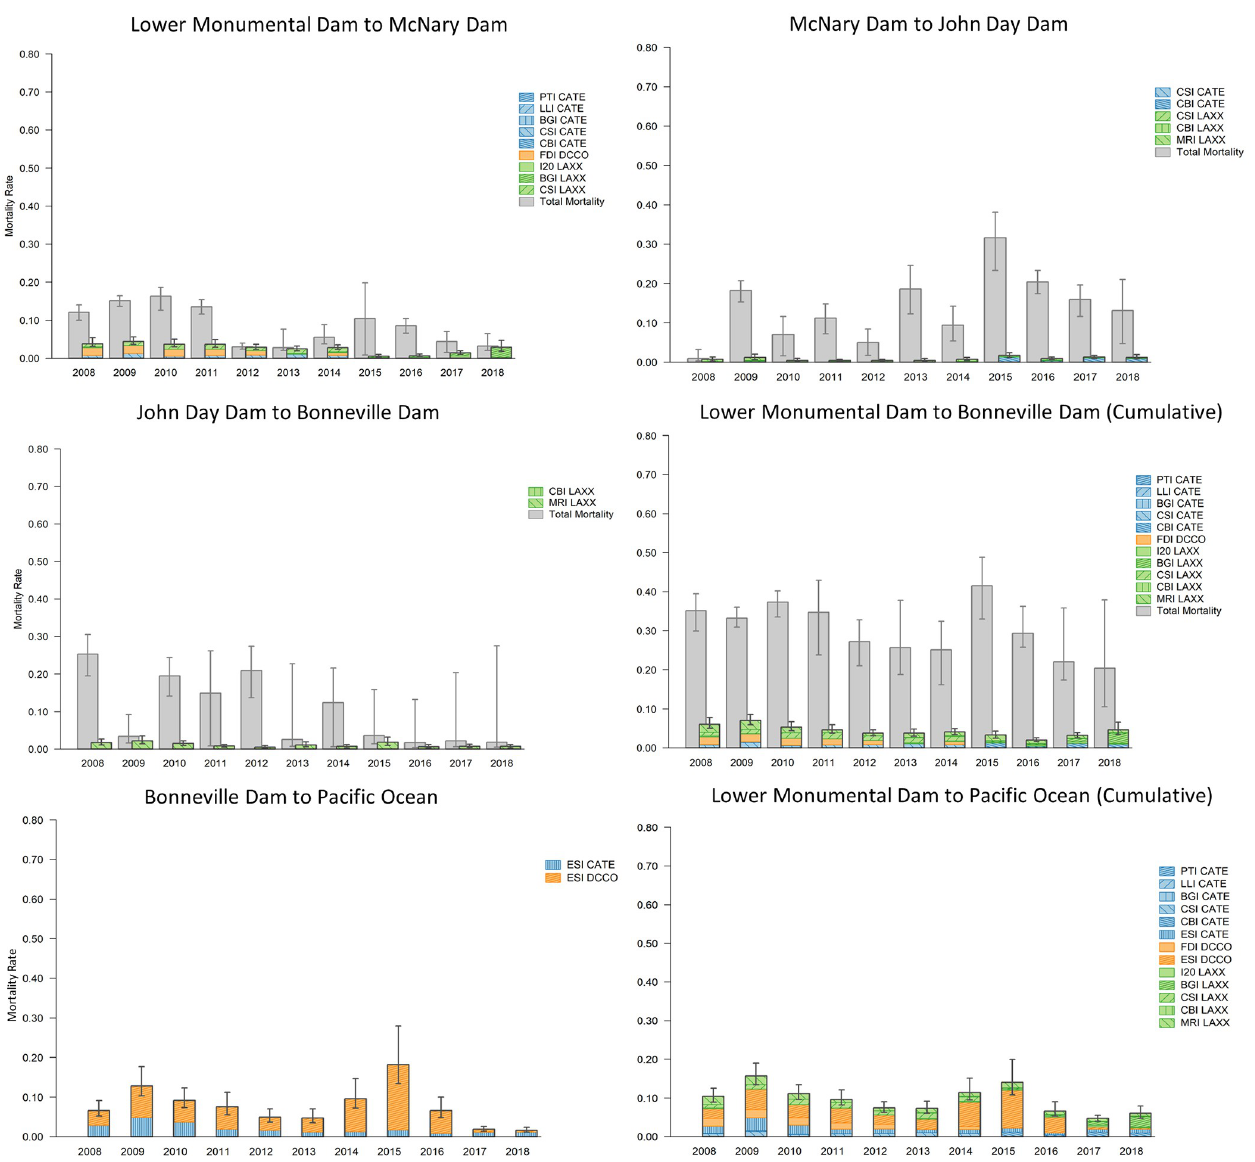
Fig 3. Avian consumption and total mortality of snake river yearling Chinook salmon. Estimated annual colony-specific, reach-specific, and cumulative avian consumption probabilities (colored bars) compared to total mortality (grey bars) of Snake River yearling Chinook salmon smolts during passage from Lower Monumental Dam on the Snake River to the Pacific Ocean. Piscivorous waterbird colony locations include Banks Lake Island (BLI), Potholes Reservoir (PTI), Lenore Lake Island (LLI), Island 20 (I20), Foundation Island (FDI), Badger Island (BGI), Crescent Island (CSI), central Blalock Islands (CBI), Miller Rocks Island (MRI), and East Sand Island (ESI). Avian species include Caspian terns (CATE), double-crested cormorants (DCCO), and California and ring-billed gulls (LAXX). Error bars represent 95% credible intervals for total mortality and avian